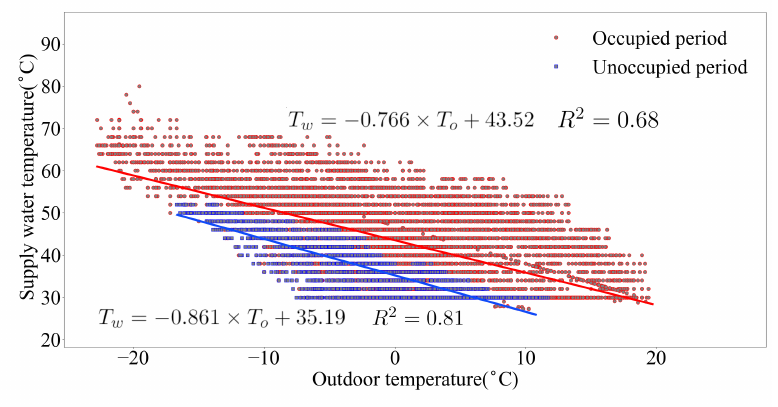
Figure 8. Supply water temperature profiles for both occupied and unoccupied periods under various outdoor